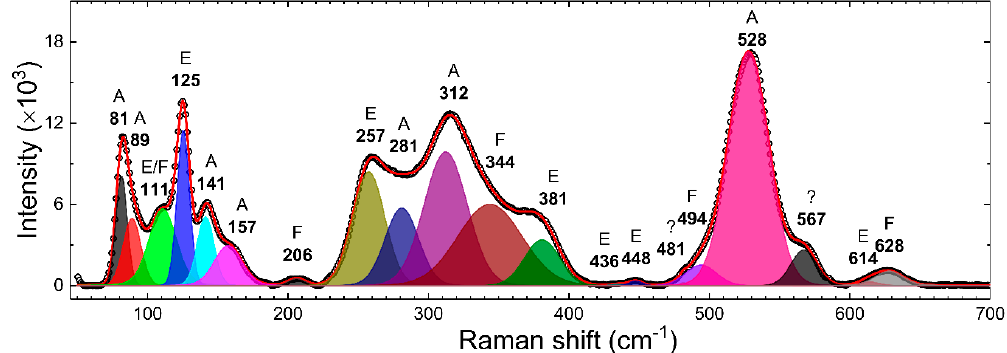
Figure 3. Deconvoluted (red line) room temperature (RT) Raman spectra (open dots) of γ –Bi 2 O 3 NPs. The fitted values of frequencies and the corresponding vibration modes (A, E, and F) are